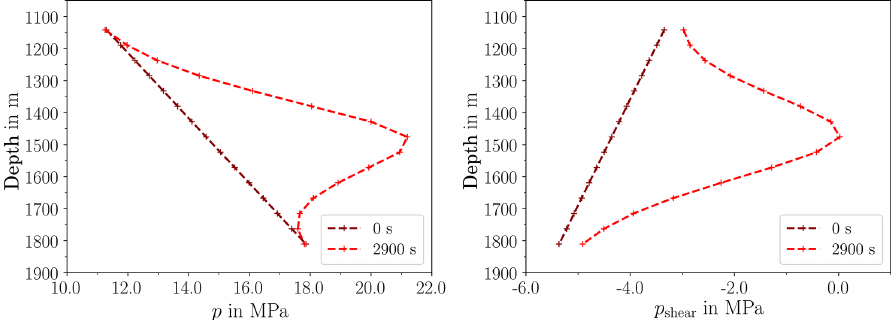
Figure 3. Pressure p and pressure margin p shear for shear failure along fault at t = 0s and t = 2900s. p shear is the difference between the effective pore pressure and the critical pressure for failure.